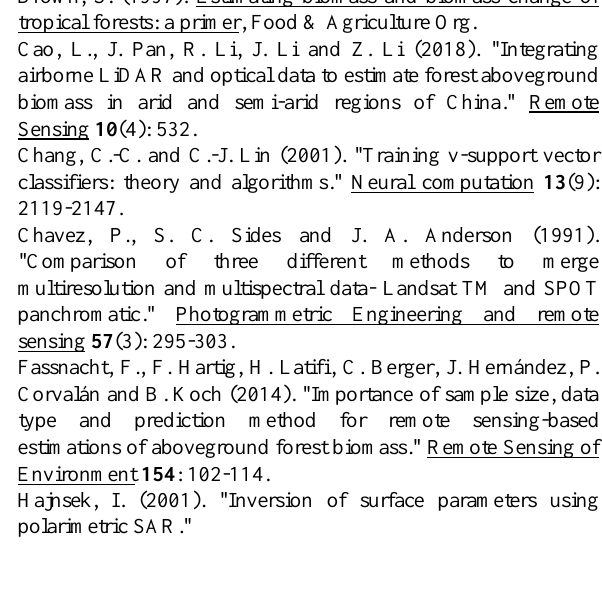
Figure 9. Carbon stock of urban forest in 2005